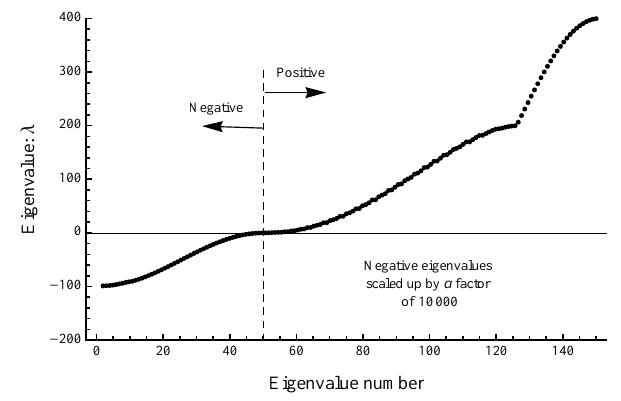
Fig. 4. The eigenvalue spectrum for the standard Stokes system, Eq. (51). Note that negative eigenvalues have been greatly amplified for clarity.